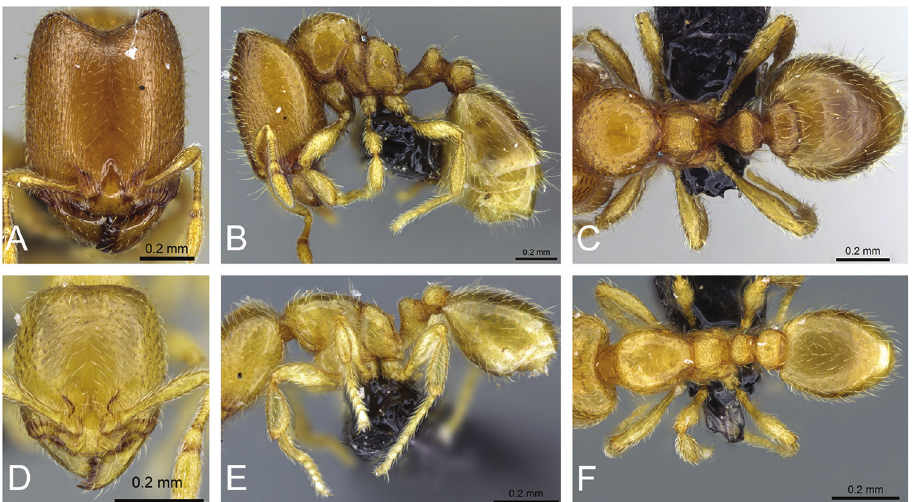
Figure 59. Carebara raberi –holotype. Major worker, CASENT0140594: A head in full-face view B body in profile view C body in dorsal view. Minor worker, CASENT0140575: D head in full-face view E body in profile view F body in dorsal